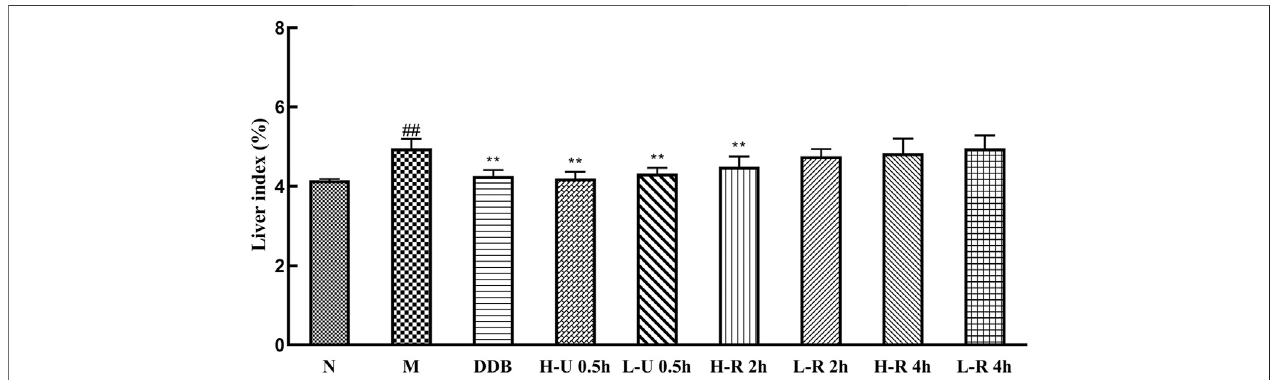
FIGURE3| Comparisonofmouseliverindex( x ± s, n (cid:1) 6).Comparedwithnormalcontrolgroup(N), # p < 0.05, ## p < 0.01;comparedwithmodelcontrolgroup(M), * p < 0.05, ** p <